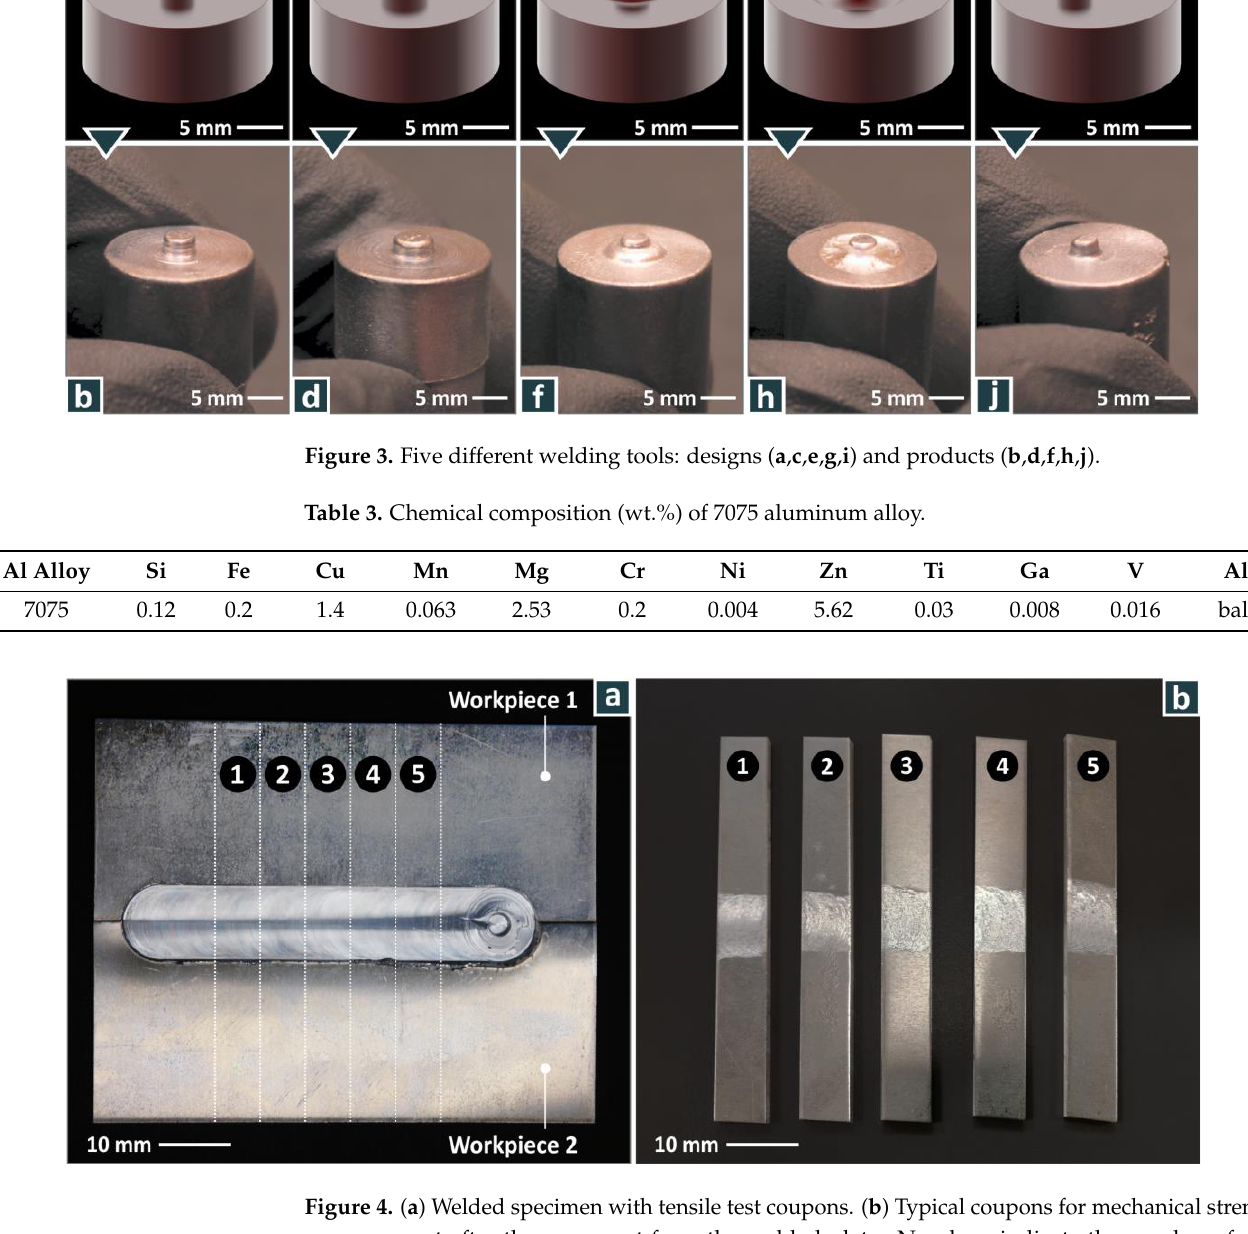
Figure 4. ( a ) Welded specimen with tensile test coupons. ( b ) Typical coupons for mechanical strength measurement after they were cut from the welded plate. Numbers indicate the number of each sample in the tests.